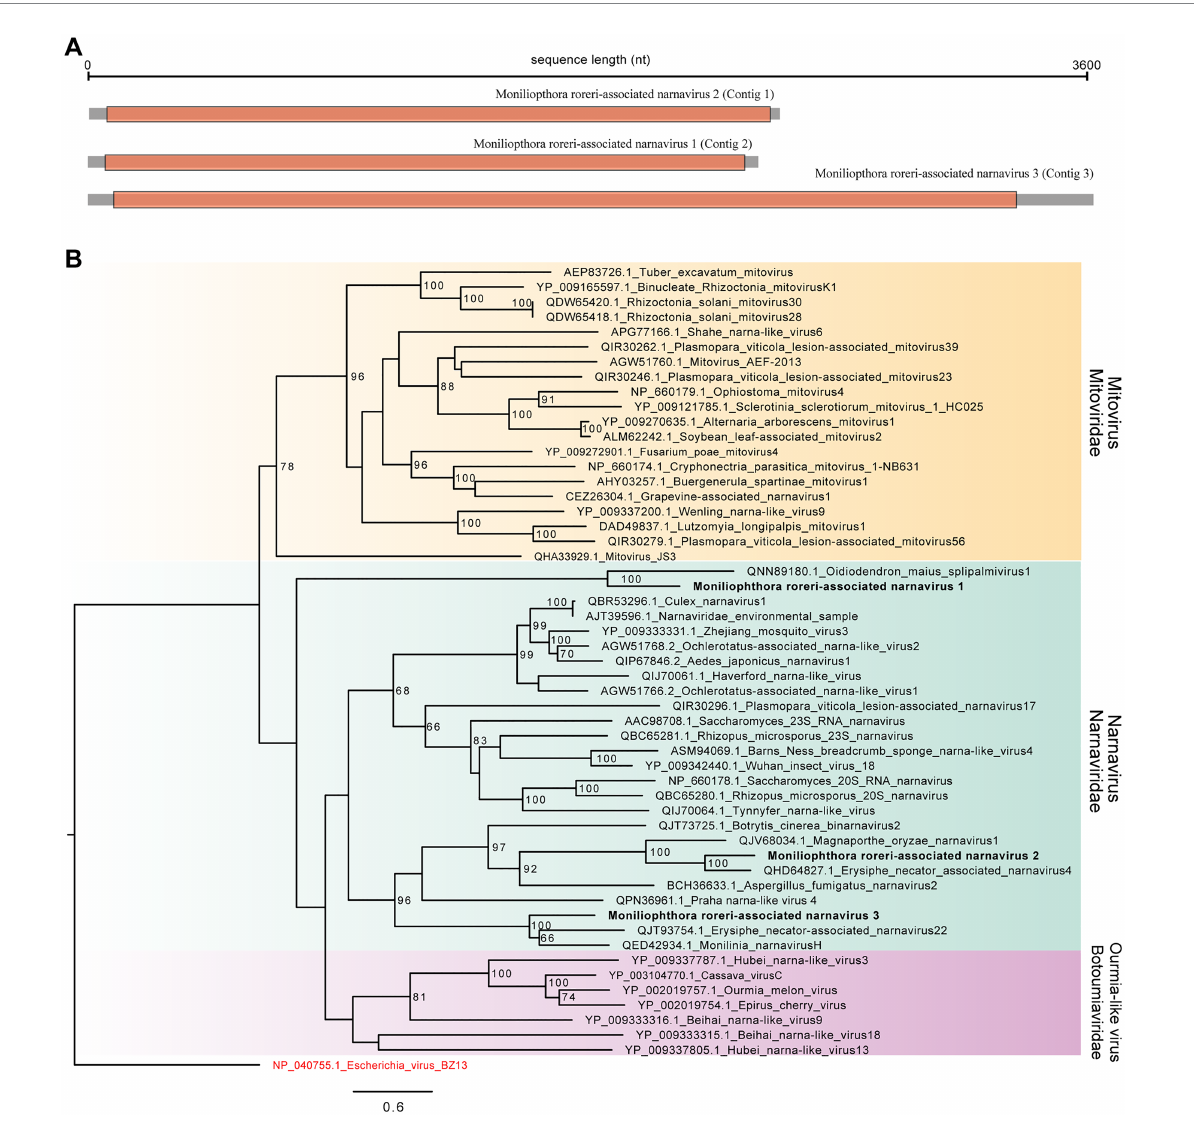
FIGURE 2 Characterizations of Moniliophthora roreri -associated viral sequences. (A) Genomic structure of M. roreri associated viruses. Gray square represents the whole viral segment while orange region indicates the large Open Read Frame. (B) Maximum likelihood tree constructed based on large viral ORF translated into protein. Viral sequences identified in the work are highlighted in bold. Bootstrap values larger than 60 are indicated in the